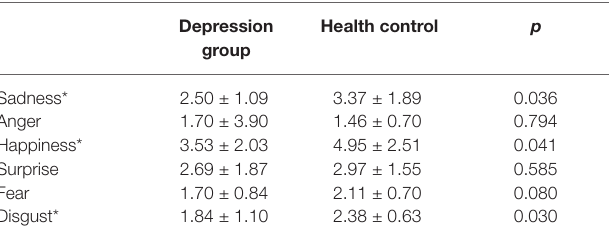
TABLE 2 | Facial expression recognition between depression group and health control